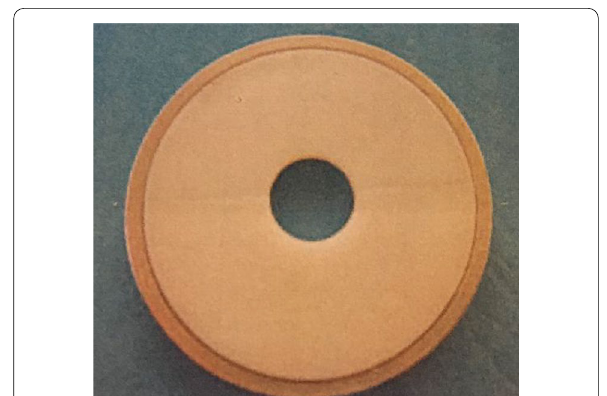
Fig. 2 Teflon mold with the outer stabilizing